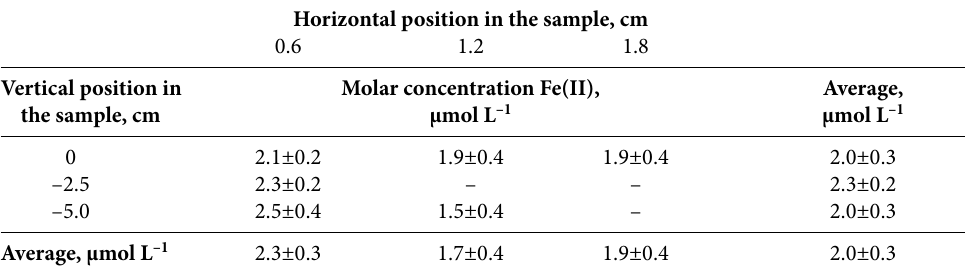
Table 1. Concentrations of the Fe(II) ions in the Chelex-100 resin. (The “–” sign indicates data lower than the LOD.) Horizontal position in the sample, cm